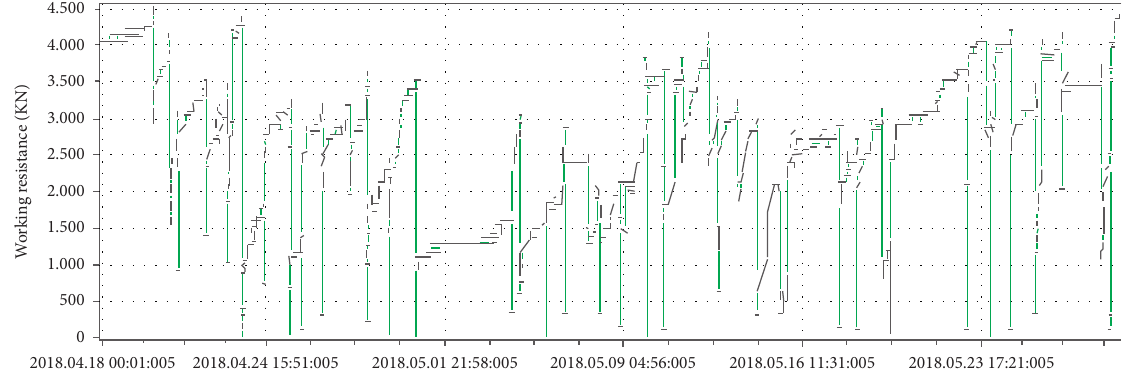
Figure 6: 5 #online monitoring of working resistance of extension support (2018.04.18–2018.05.23).